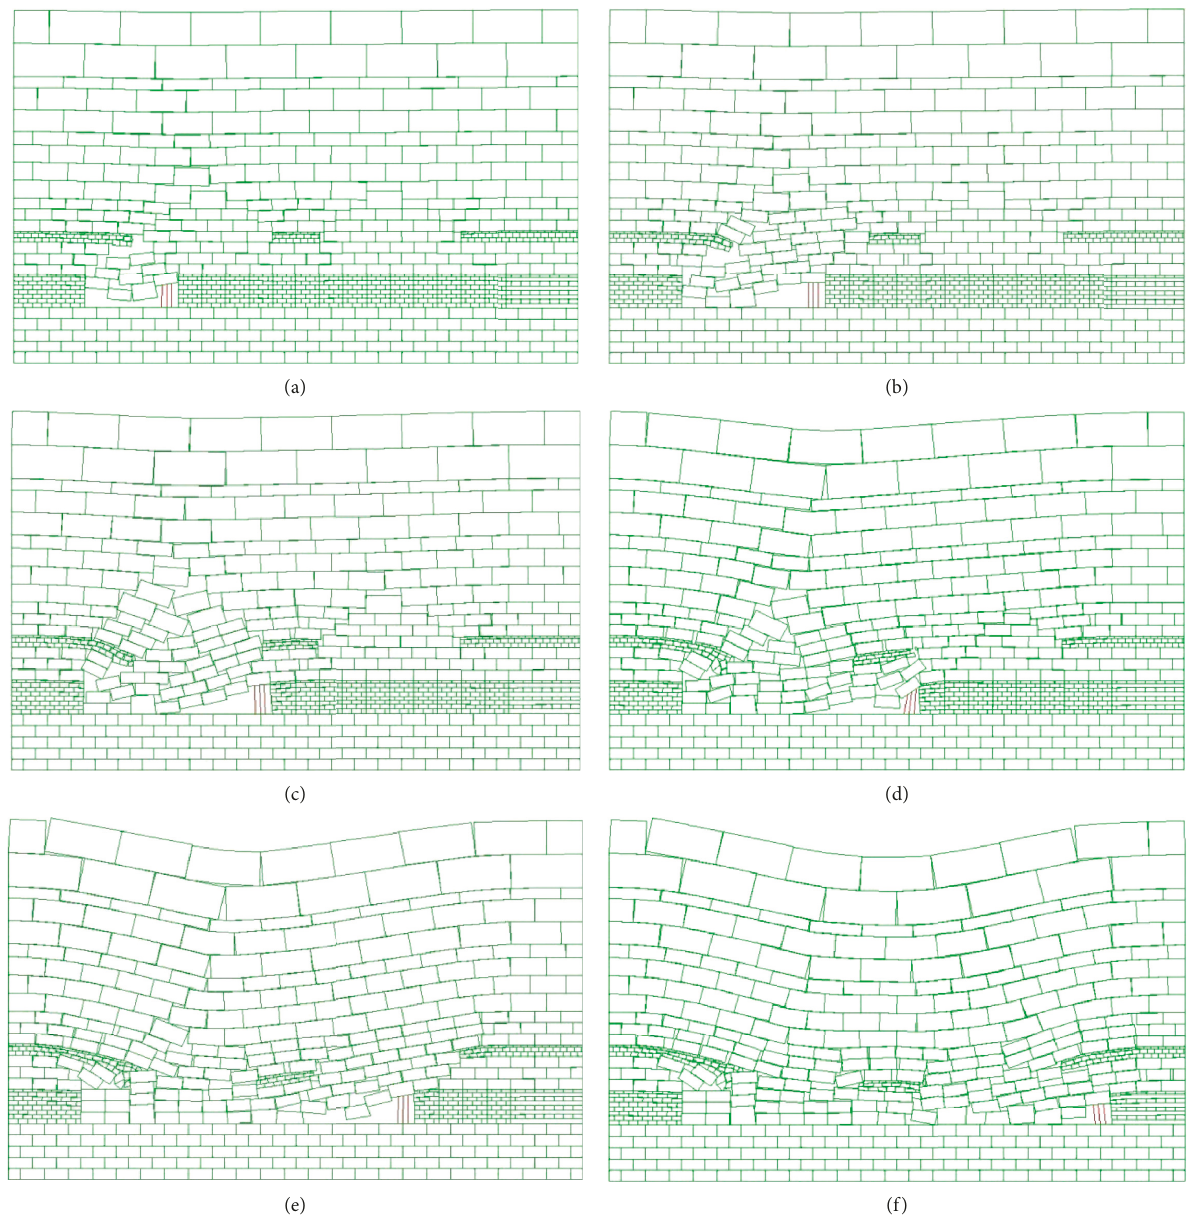
Figure 5: The evolution diagram of collapsing characteristics of overburden rock in the 15m interlayer. Advance of the working